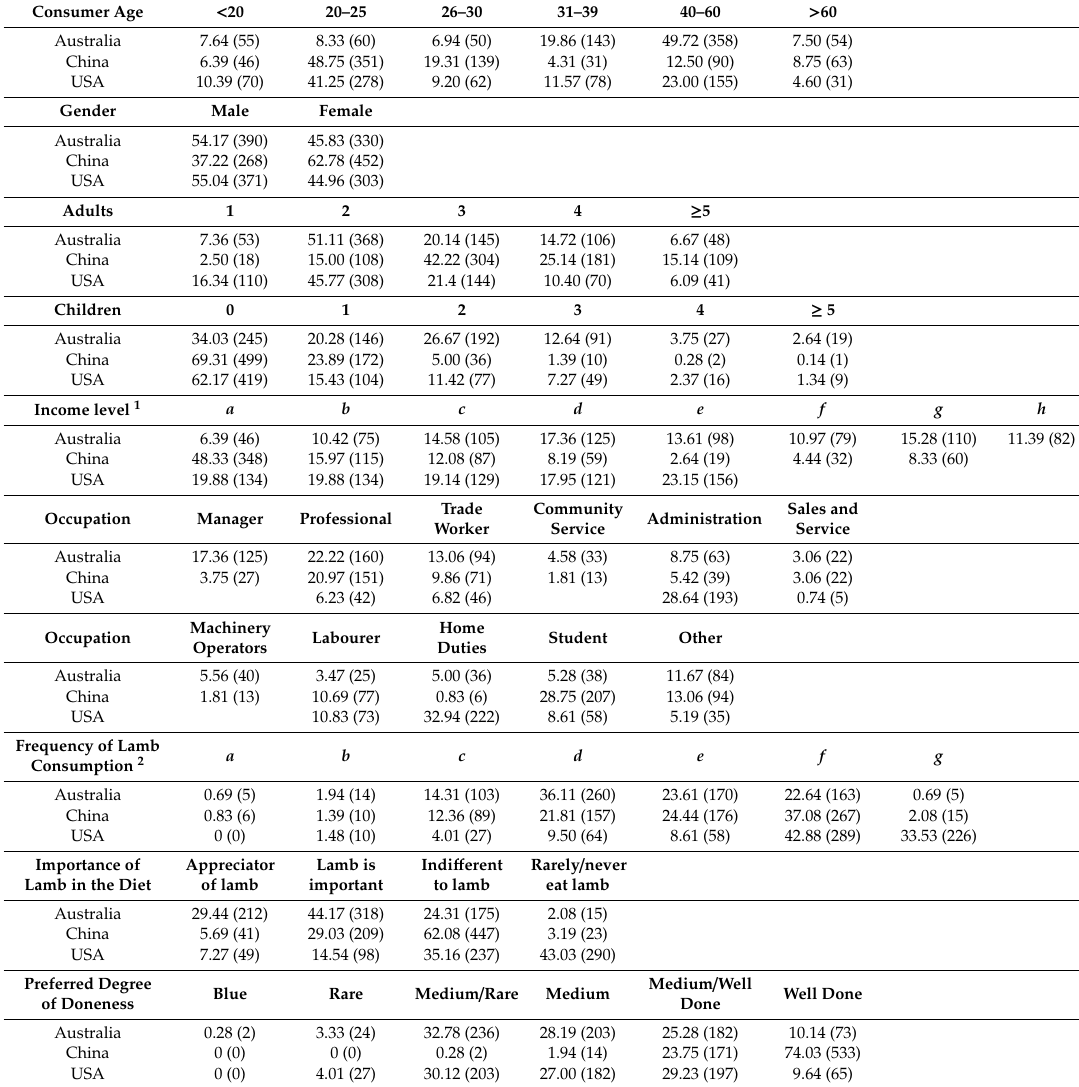
Table 1. Percentage distribution of consumers who scored sheepmeat samples (and number of consumers) within each demographic and meat consumption category for each